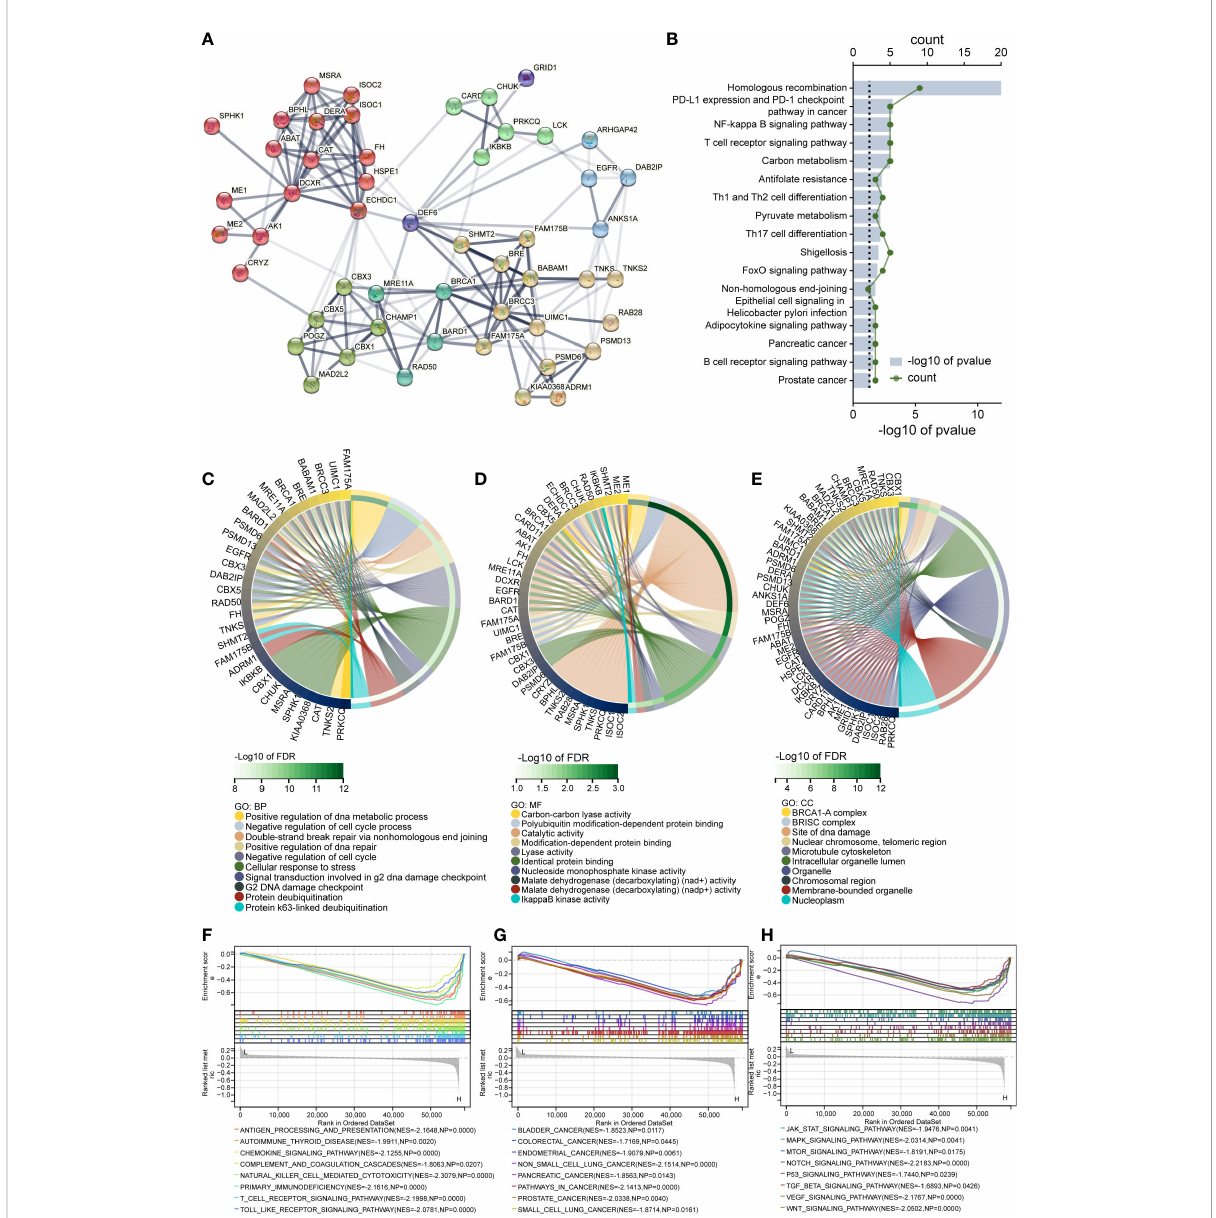
FIGURE 9 The results of DEF6 enrichment analysis. (A) Protein – protein network of DEF6 generated by the STRING database. (B) Top terms of KEGG enrichment analysis of protein – protein interaction networks. The chord diagram shows the (C) BP, (D) MF, and (E) CC results of GO enrichment analysis. (E – G) Results of enrichment analysis of GSEA in colorectal cancer. CC, cellular component; BP, biological process; MF, molecular function; GO, gene ontology. KEGG, Kyoto encyclopedia of genes and genomes. p -values are adjusted using the FDR method in GO and KEGG